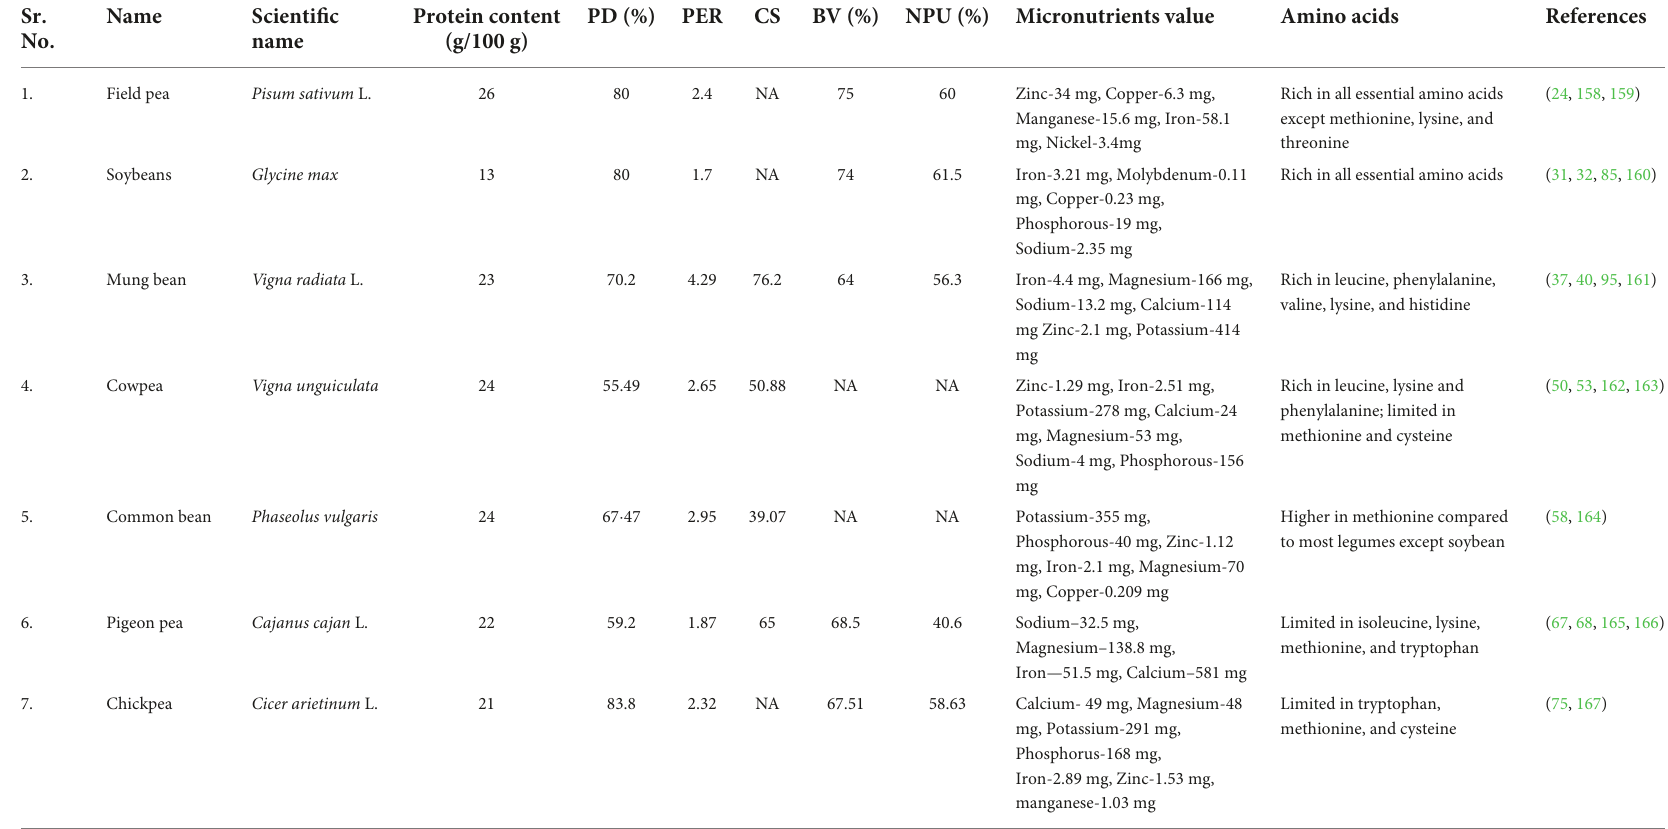
TABLE 1 Protein content, PD, PER, CS, BV, NPU, micronutrients and amino acids information of cultivated legumes. Sr. No.